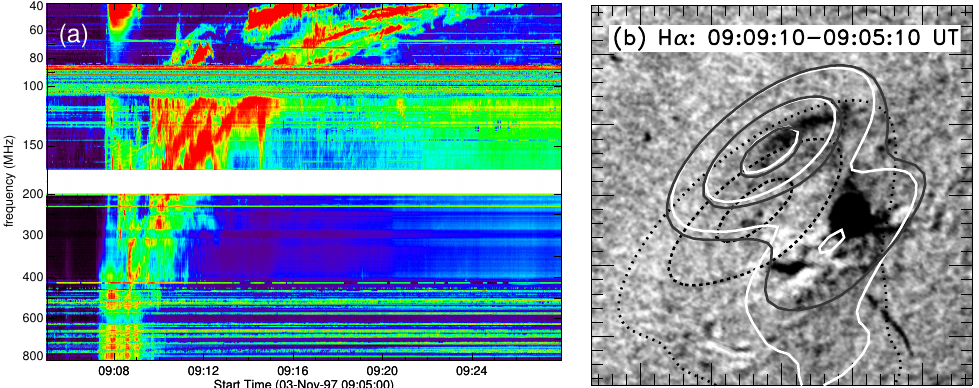
Figure 14: (a): metric type II radio burst associated with the coronal wave of 1997 Nov 3 as seen in a dynamic radio spectrum (source: Potsdam-Tremsdorf radiospectrograph). Both fundamental and harmonic emission bands are seen, and each band is split into two emission lanes. (b): H α difference image (with reversed gray scale; source: Kanzelh¨ohe Solar Observatory) showing the Moreton wave associated with the same event. The overplotted contours show the type II burst source as imaged by the Nan¸cay radioheliograph. Note that the burst source is cospatial with the Moreton front. Image reproduced with permission from Khan and Aurass (2002), copyright by